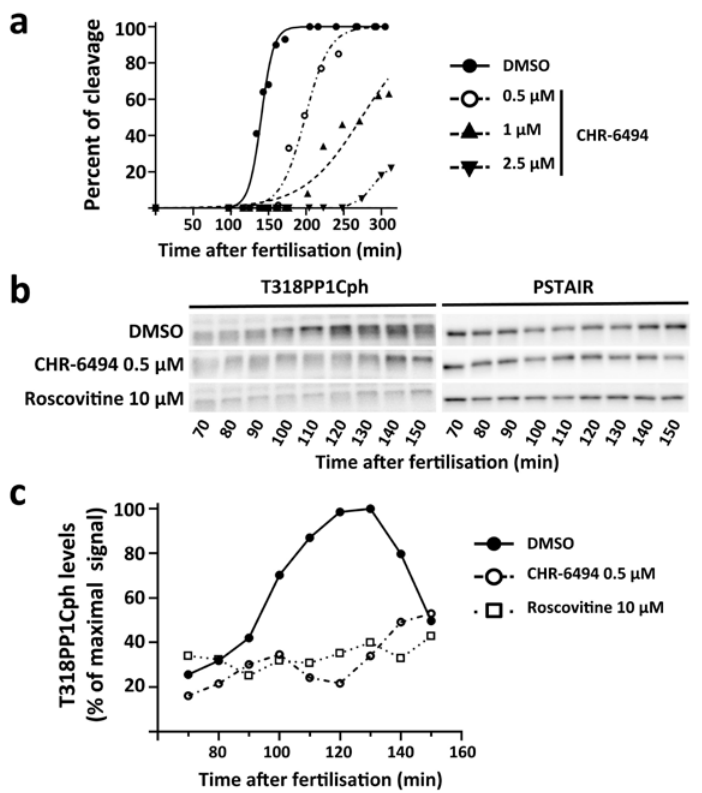
Figure 5. Exposure to the CHR-6494 inhibitor delays cell division in S. granularis early embryos. ( a ) Graph representing the proportion of embryos that have completed the first cleavage at different time points (min after fertilisation). The different curves describe culture behaviour in the presence of increasing concentrations of CHR-6494 or its vehicle DMSO, all added at 15 min after fertilisation. ( b ) Relative levels of T318PP1Cph observed at different time points in embryos treated with DMSO, 0.5 µM CHR-6494 or 10 µM Roscovitine. The T318PP1Cph form was detected by Western blot using a specific antibody. The levels of CDK1 were visualised in the same membrane with the PSTAIR antibody and used as a loading control. ( c ) Quantitative analysis of the above results. Plotted values were normalised against the CDK1 levels and expressed as a percentage of the maximal signal observed.